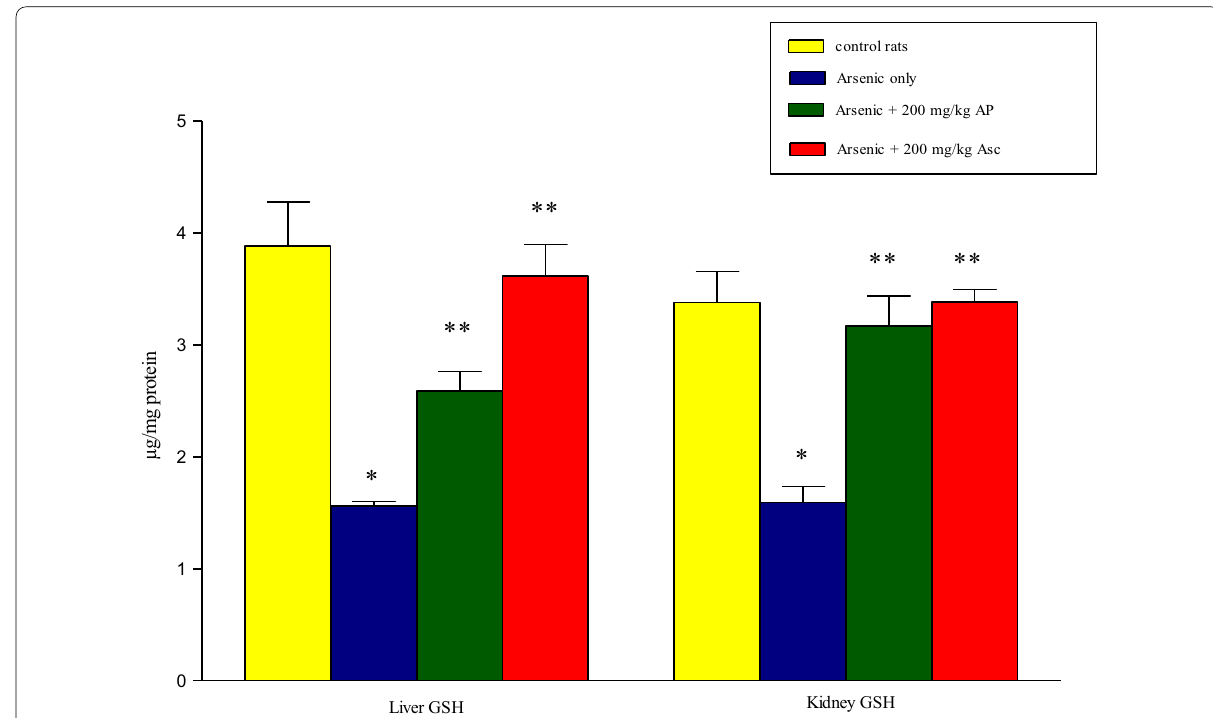
Fig. 2 Effect of methanolic extract of A. paniculata on hepatic and renal GSH levels in arsenic-induced rats. Values are mean *( p < 0.05) Group 2: (arsenic group rats) compared with group 1: (control rats). **( p < 0.05) Groups 3 and 4: ( A. paniculata or ascorbic acid administered rats, respectively) compared with group 2: (arsenic group